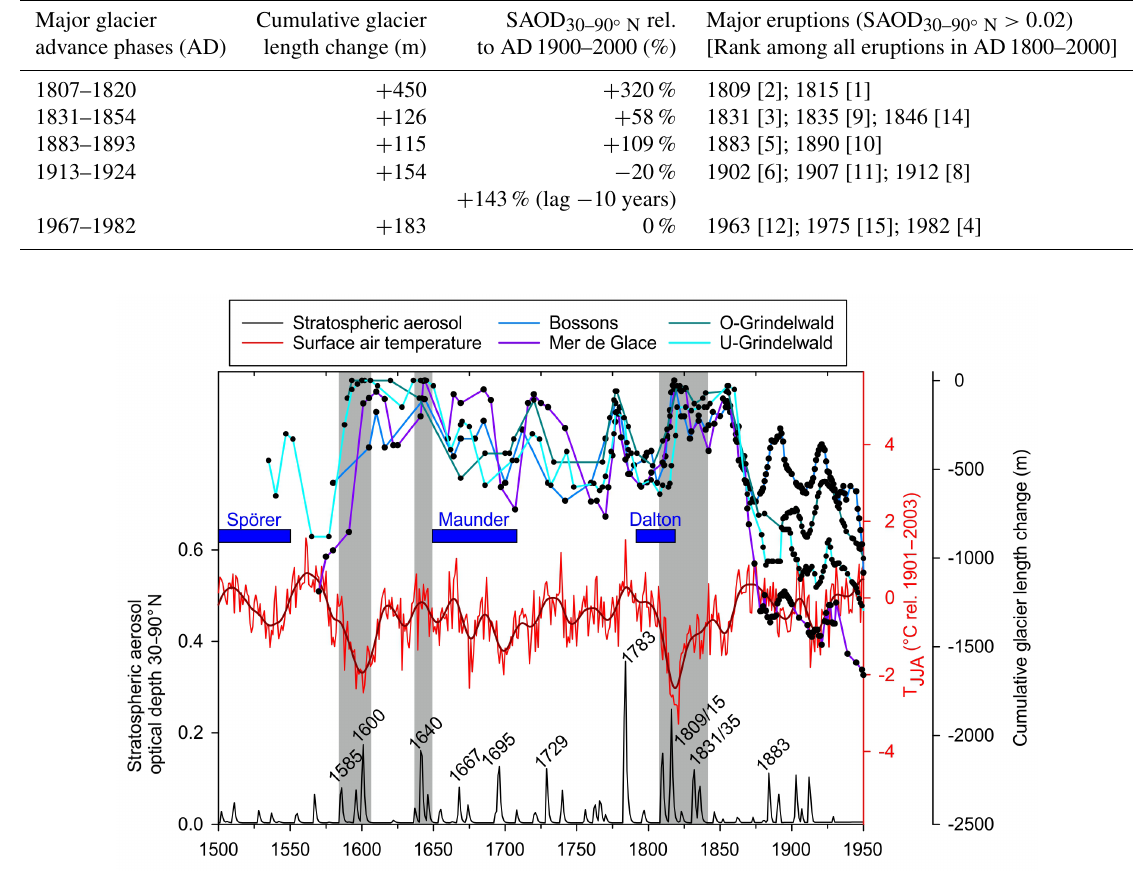
Table 5. Alpine glacier advances and volcanic eruption dates and resulting stratospheric aerosol properties (see Fig. 8).